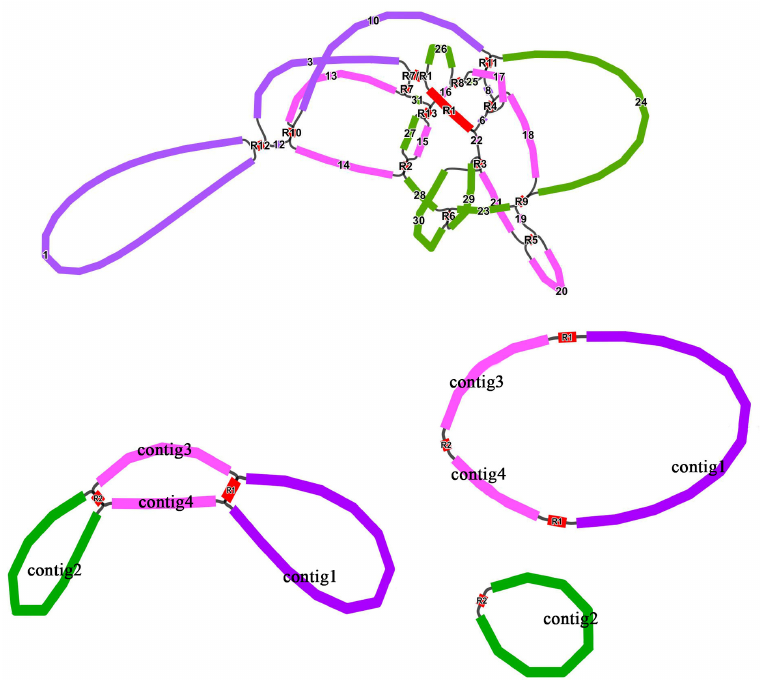
Figure 3. The assembly graph of the C. speciosa mitochondrial genome. Colored segments were named contig/R 1–15. Long reads supported all segment adjacencies.